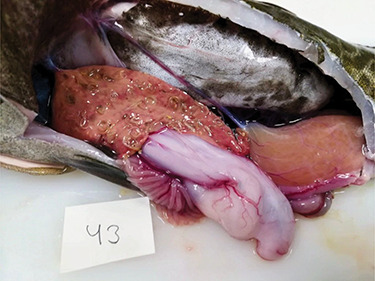
 An example of a G. morhua with a liver having a high density of C. osculatum (19 nematodes per gram liver tissue), some visible on the surface of the organ, others hidden in the liver parenchyma